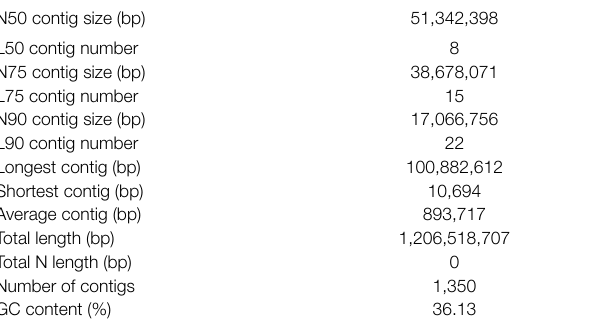
TABLE 1 | Assembly statistics of the Aralia elata